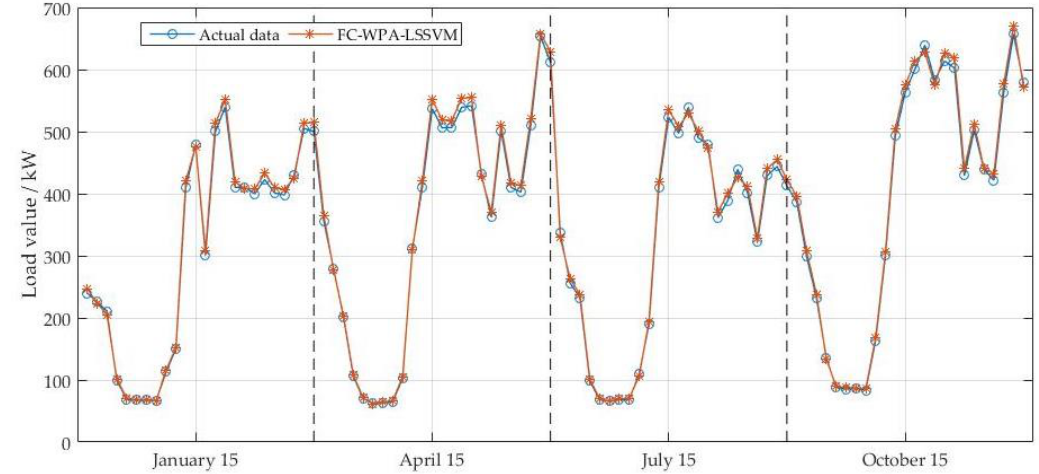
Figure 7. Forecasting results of the proposed model.